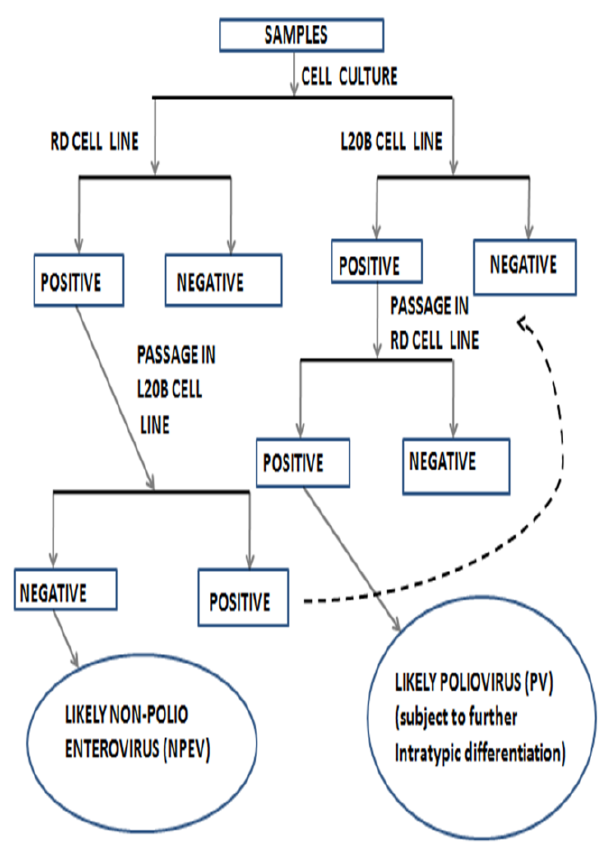
Figure 1. Poliovirus (PV) isolation algorithm as recommended by the World Health Organization (2003, 2004).